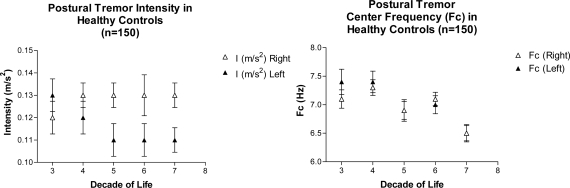
Tremor Parameters in Healthy Controls. Left panel shows postural tremor intensity as a function of decade of life. Right panel shows Center frequencies of postural tremor against decade of life. Data are derived from accelerometer recordings of postural tremor using the Catsys Accelerometer system in 150 healthy controls (75 females and 75 males). Data were plotted from a published table of normal values [8].